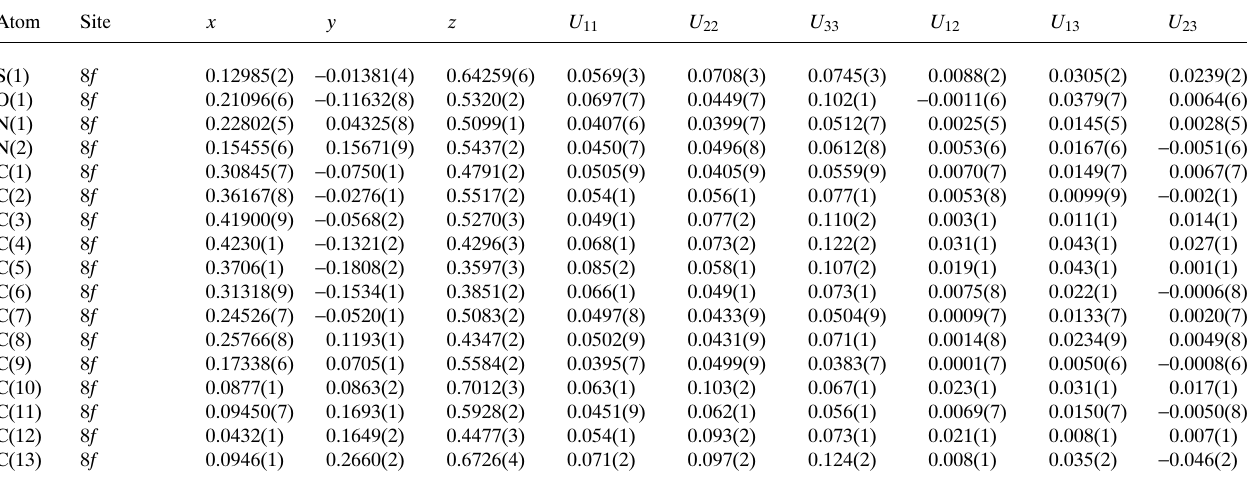
Table 3. Atomic coordinates and displacement parameters (in Å 2 )